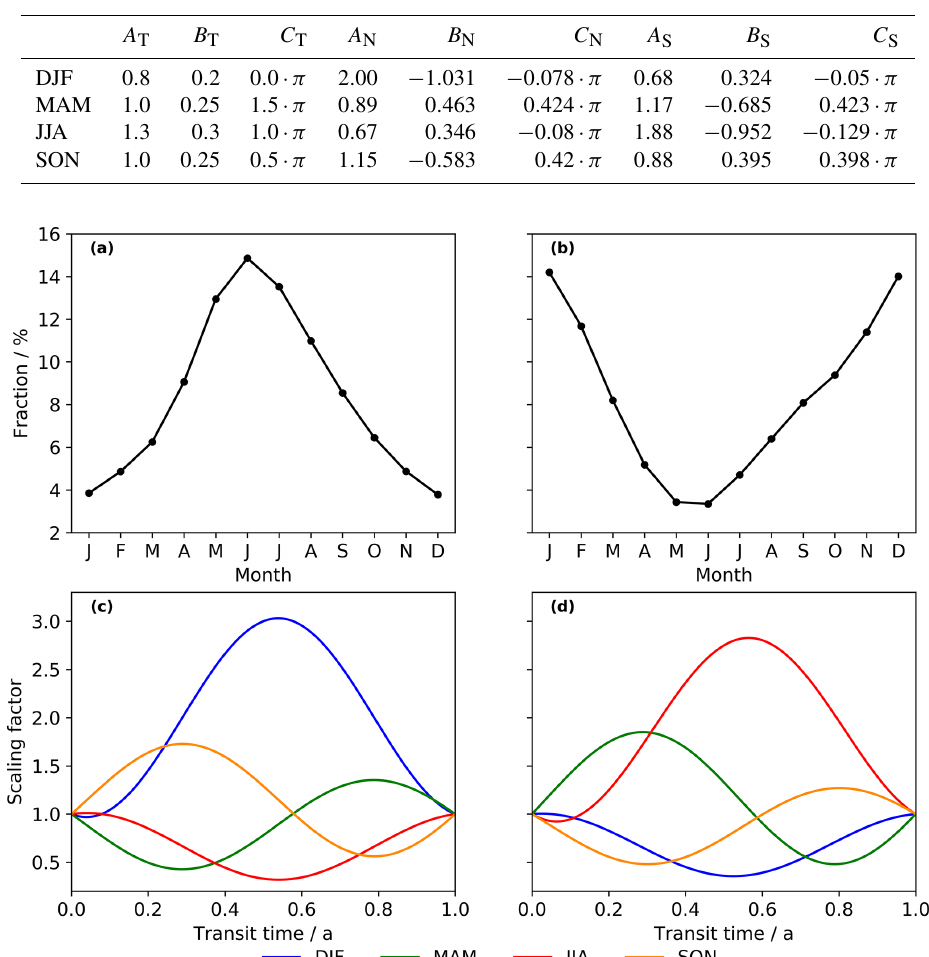
Table 1. Scaling constants of Eq. (13) for the northern, tropical, and southern tropopause sections (N, T, S) in all four seasons. The tropical values are taken from Hauck et al. (2019).